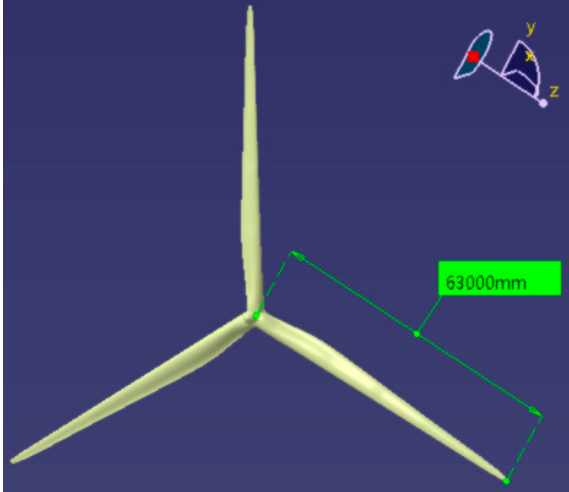
Figure 19. 3D model of the designed NPU 5 MW blade.